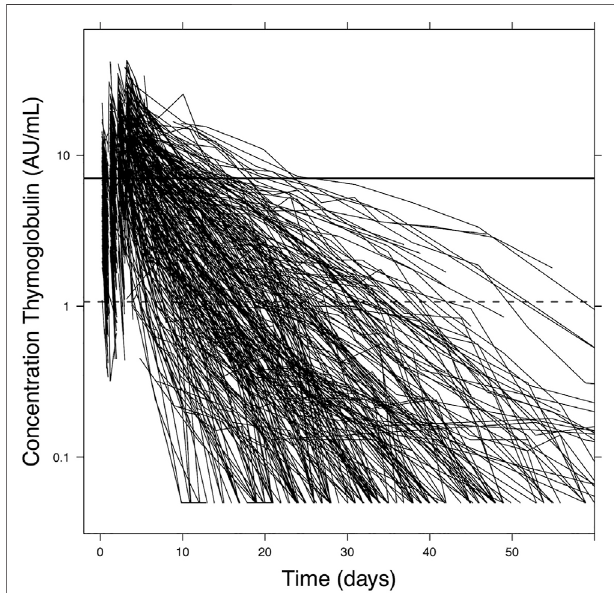
FIGURE 1 | Active ATG plasma concentration data. The graph shows aATG concentrationsovertime inpediatricpatients( n =267)duringthewhole courseofATGtreatmentupto60 daysafter fi rstdosing.ATGclearancevaries extensively between patients. Adapted from Admiraal et al., Lancet Haematology